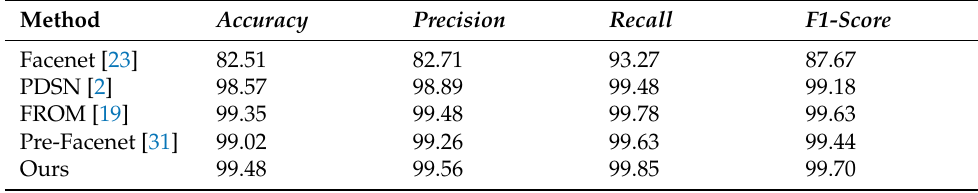
Table 5. Comparison with other state-of-the-art methods on Face-EN.